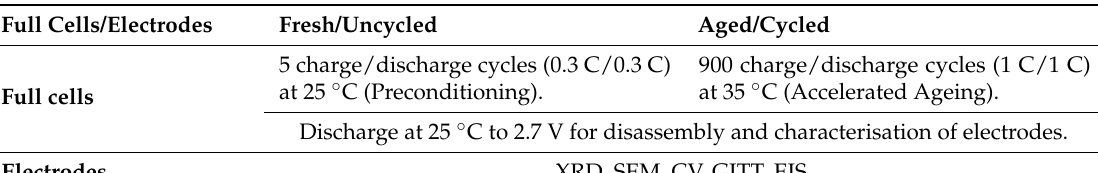
Table 1. Battery cells/electrodes and corresponding experimental